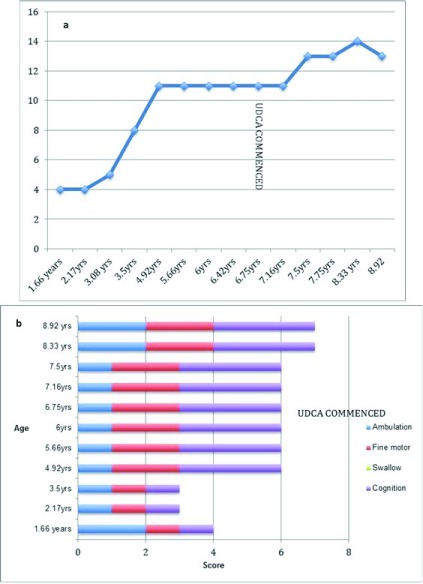
NIH scoring in Case 3.(
a) Total NIH score (without hearing and auditory brainstem response) for Case 3. Time of ursodeoxycholic acid (UDCA) commencement (6.67 yrs) marked on graph. (
b) NIH severity scale scores in the four key domains (Ambulation, Fine motor, Swallow and Cognition) for Case 3, both before and after commencement of UDCA.